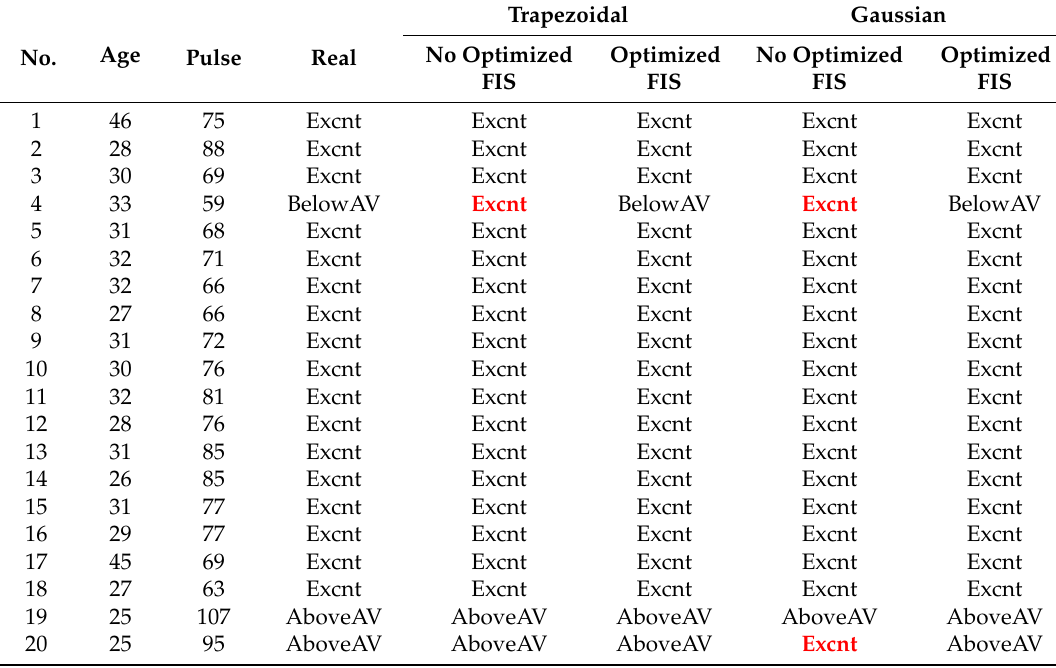
Table 15. Test with real